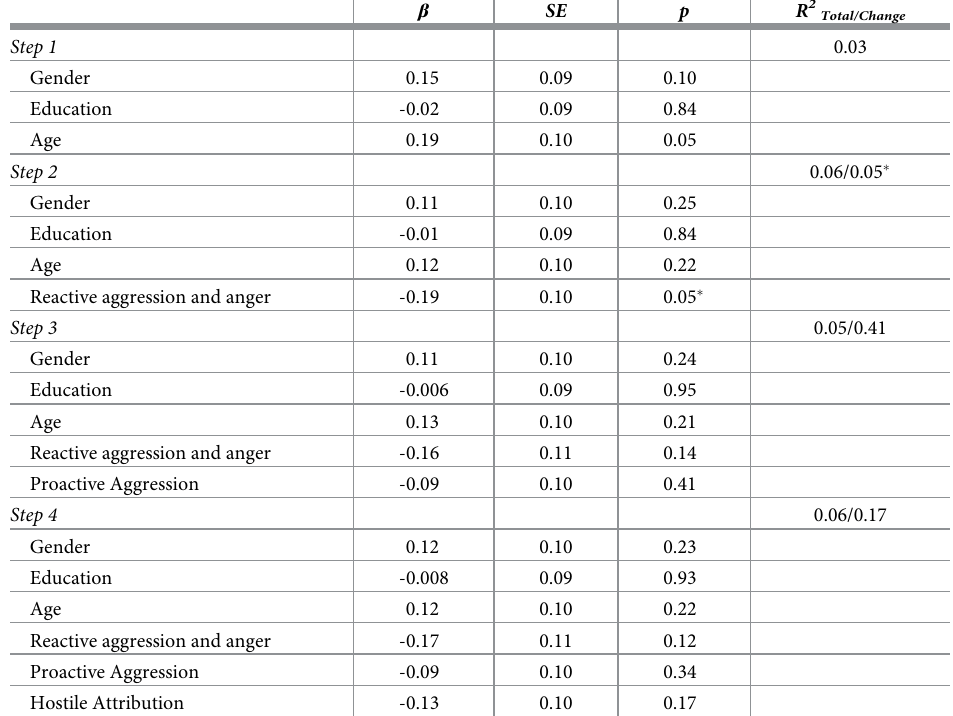
Table 3. Hierarchical multiple linear regression analysis predicting attentional bias away from angry faces whilst holding an angry face in WM (BS1 NEGATIVE ). β